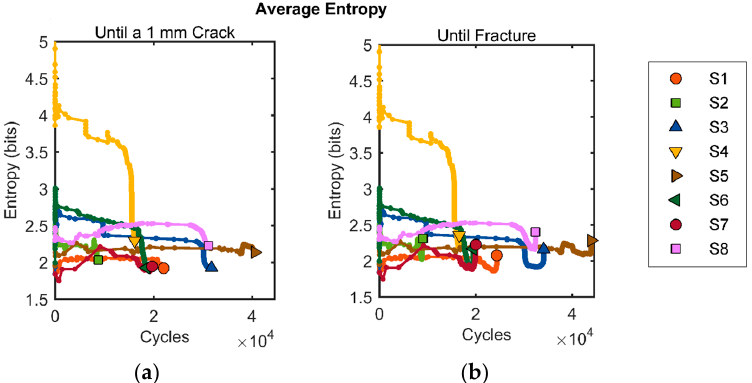
Figure 13. Average entropy trends versus fatigue cycles through two damage levels: ( a ) average entropy until a 1-mm crack; and ( b ) average entropy until fracture. Appl. Sci. 2017 , 7 , 562